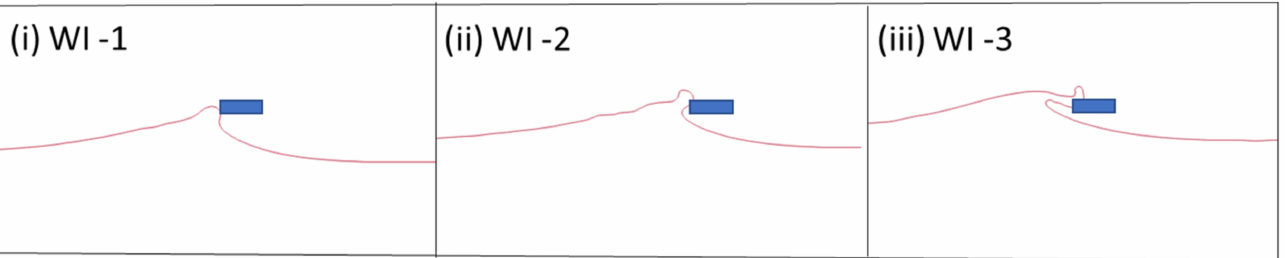
Figure 7. Schematic diagram showing different breaking wave impact scenarios ( i ) The high-crested wave steepens and becomes vertical (WI-1) ( ii ) the breaking wave slightly overturns (WI-2) and ( iii ) the overturned crest plunges to hit the preceding trough